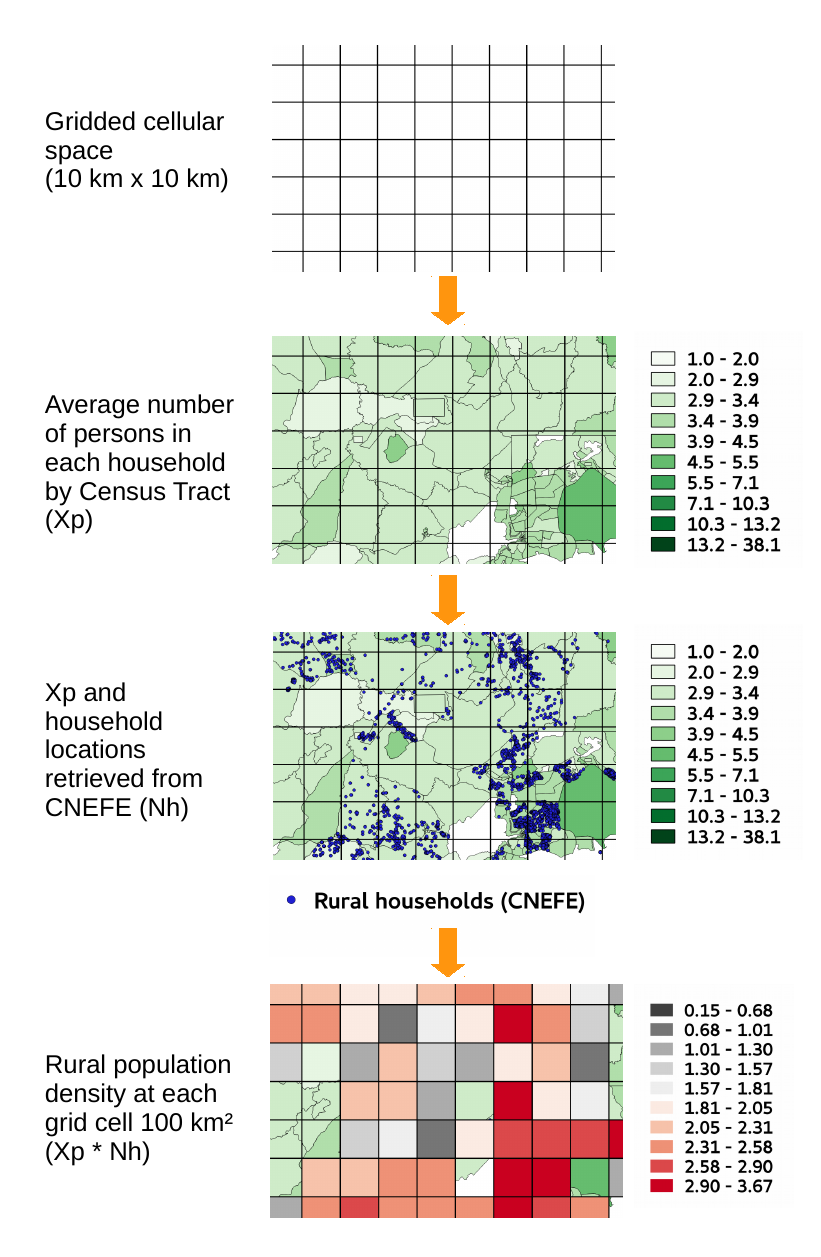
Figure 2. Flowchart illustrating the steps for spatial disaggregation of rural population in the Cerrado, based on Census tracts and household location. Data: 2010 Population Census and